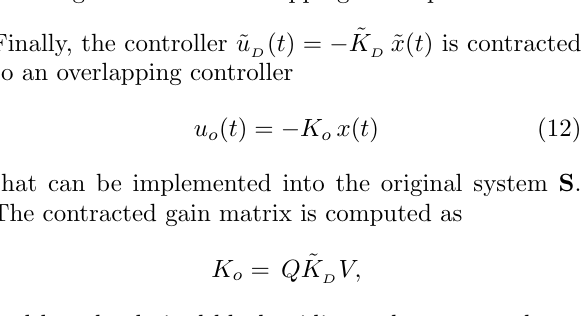
Figure 3: Multi-overlapping